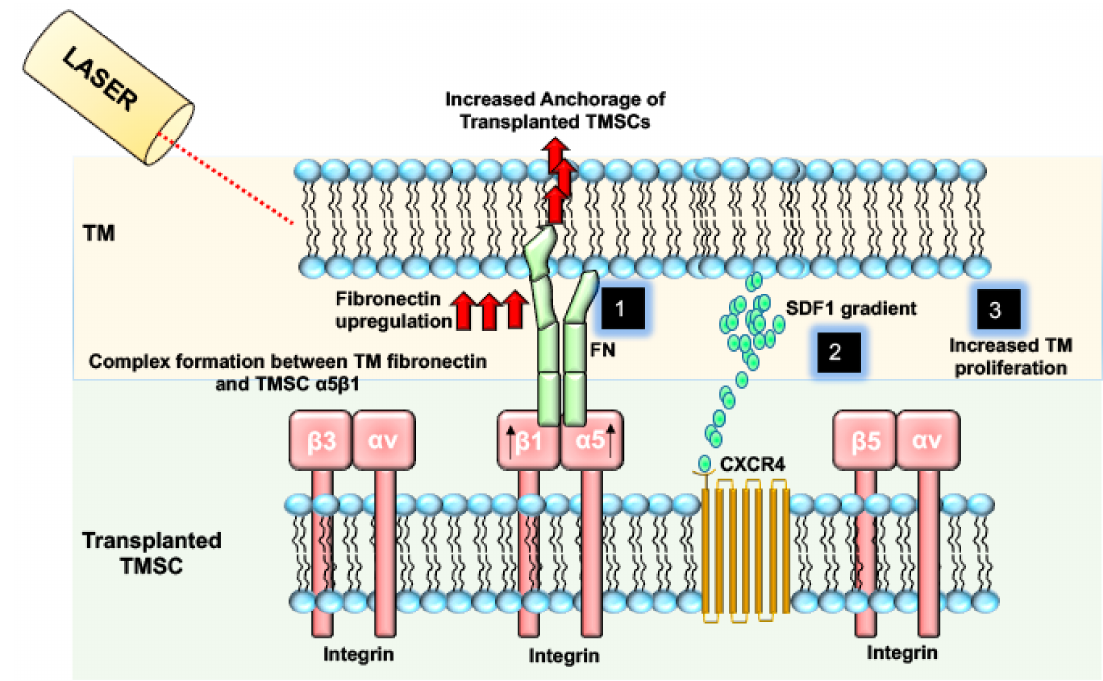
Figure 2. Transplanted TMSCs integrate into the host trabecular meshwork via various mechanisms to induce regeneration. Post Laser damage to TM results in increased FN. TMSC with high expression of α 5 β 1 Integrin can anchor to the damaged TM by forming a complex between α 5 β 1 Integrin and FN (1). TMSCs also contain CXCR4 and can bind to TM cells with an increased expression and gradient of SDF-1 (2). TMSCs can also induce the proliferation of TM cells in the TM tissue, resulting in the maintenance of TM homeostasis and reduced IOP